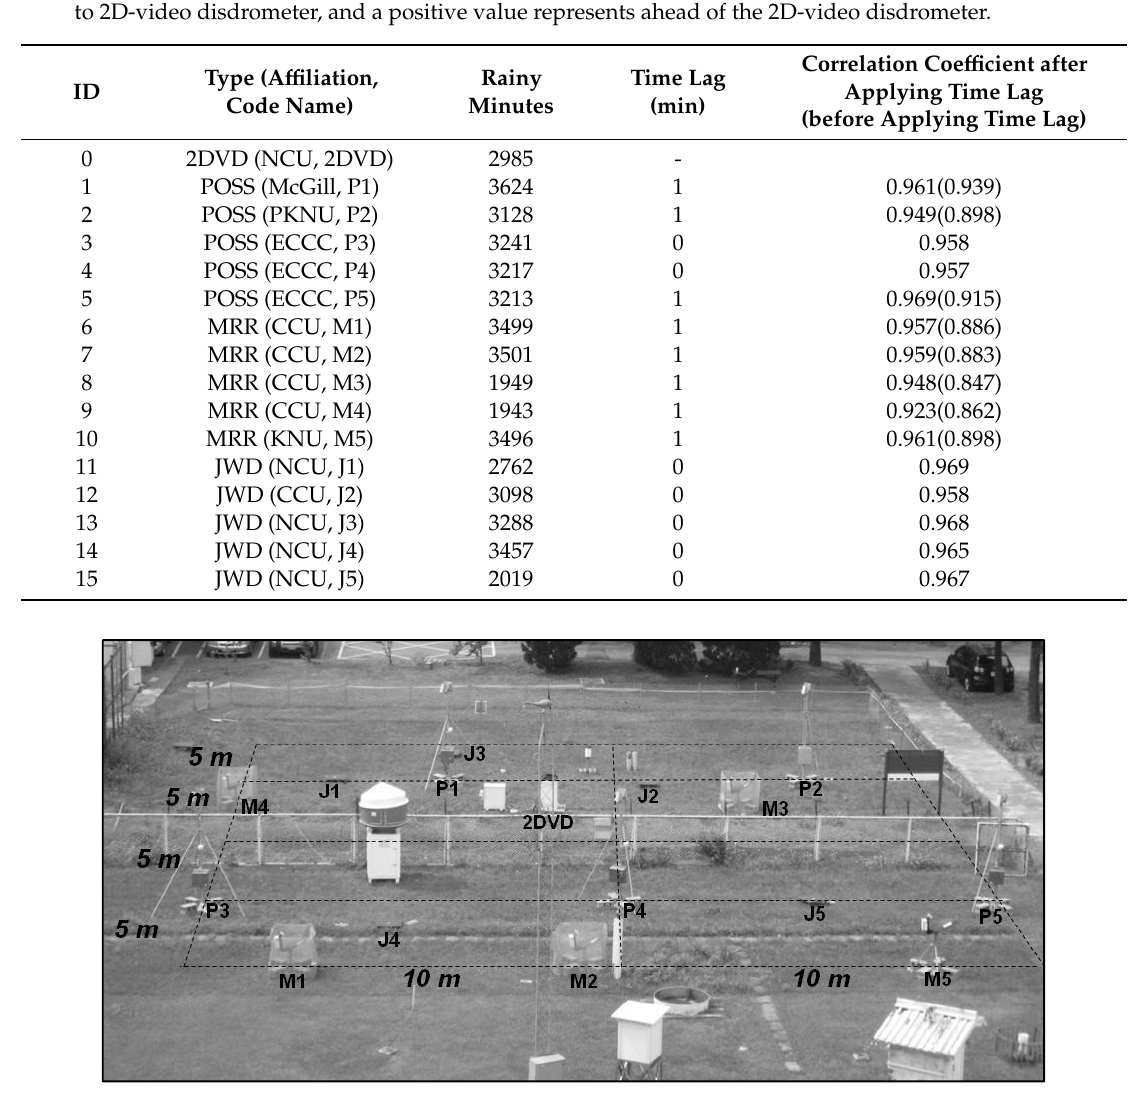
Figure 1. The layout of 16 disdrometers installed in National Taiwan University (NTU: N 0 25.0145, E 0 121.5333) during the intercomparison experiment prior to SoWMEX / TiMREX. The code names are listed in Table 1.